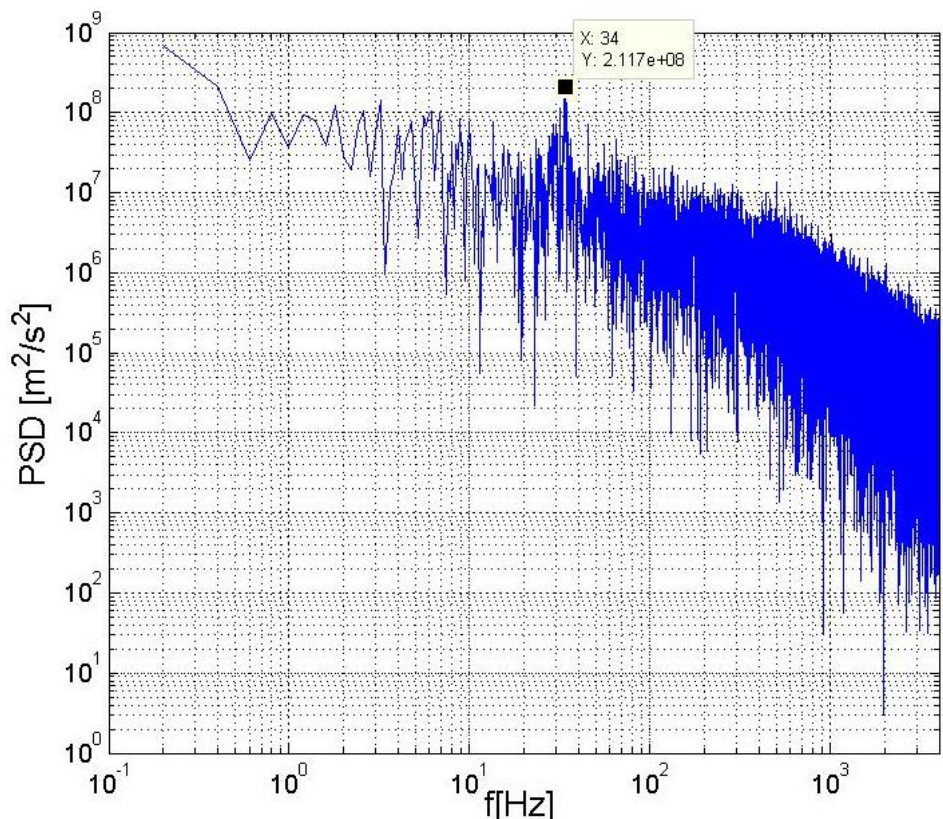
Figure 8. Power spectra along W2, Re = 100,000 and α = 24 ◦